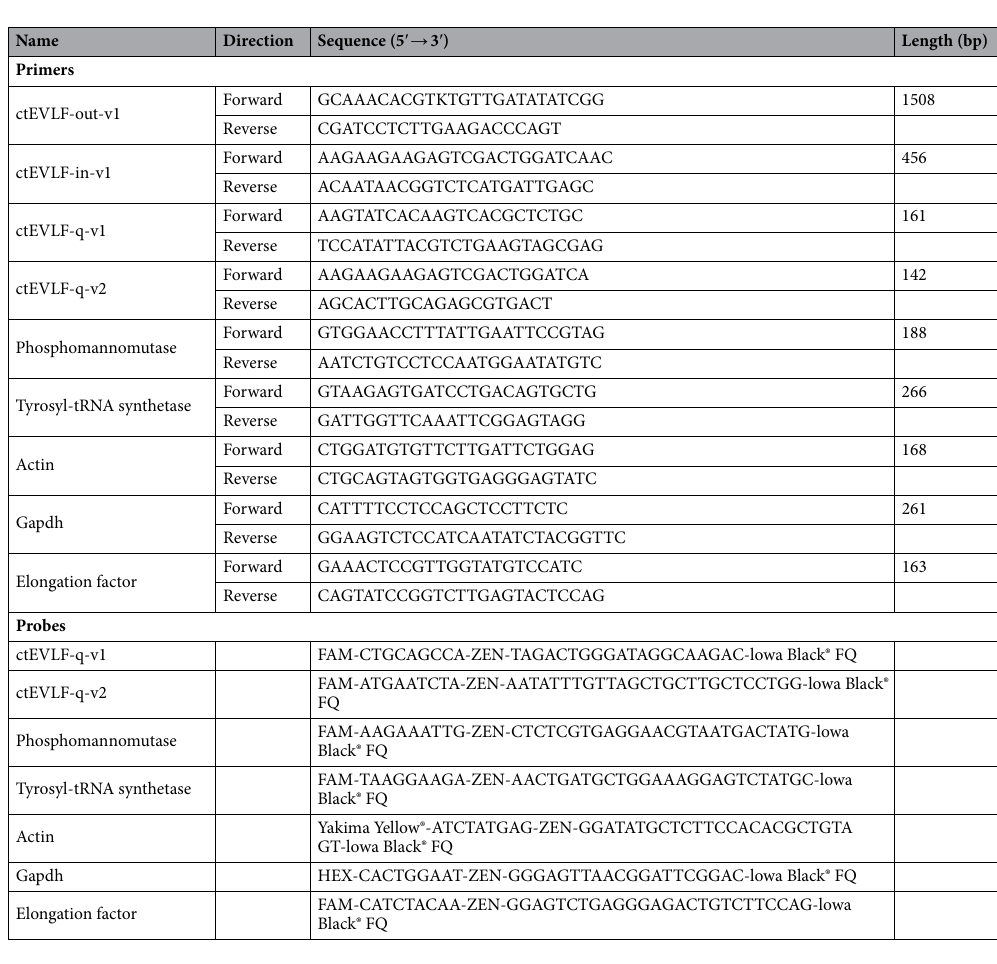
Table 2. Primer and probe sequences used in this